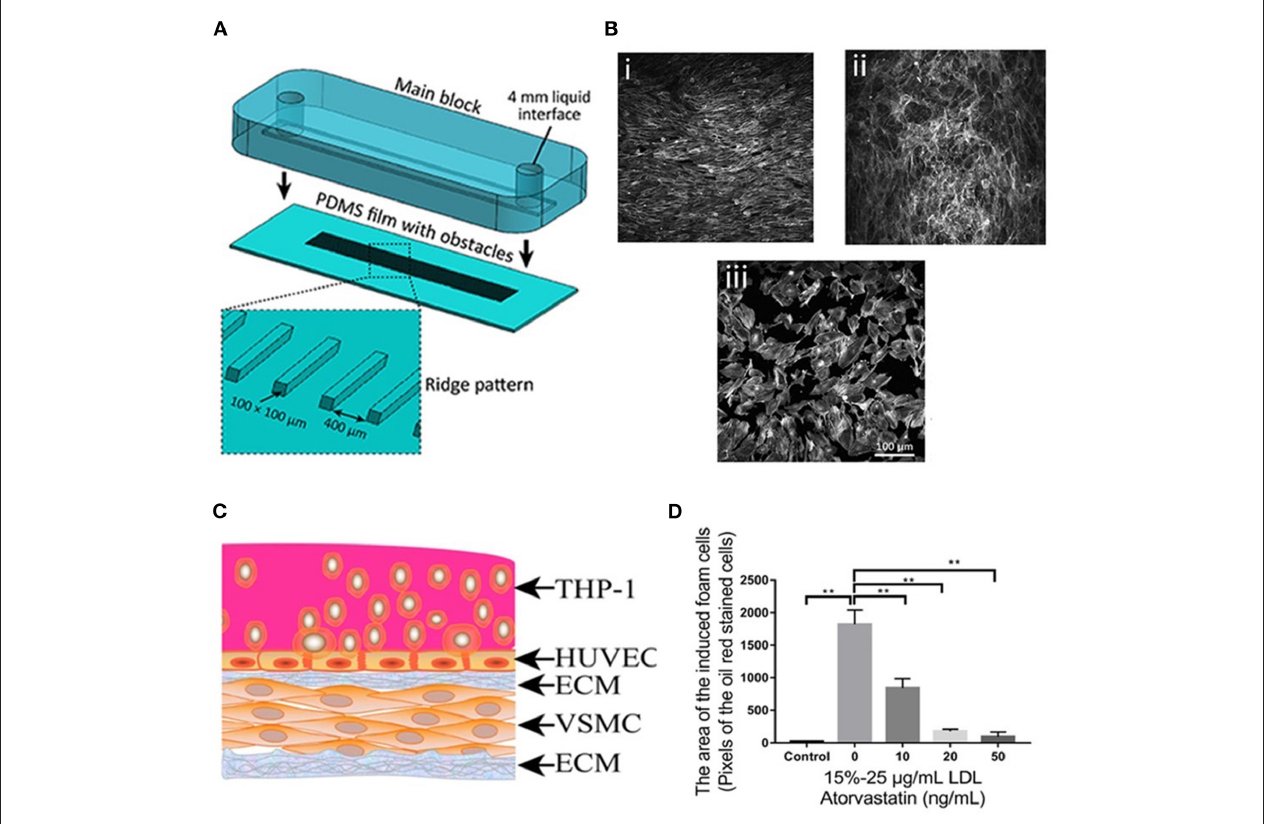
FIGURE 3 | (A) The process of assembling the main block and the PDMS substrate with ridge obstacles, with the inset showing the zoomed-in PDMS substrate. (B) A confluent layer of HAECs cultured under (i) laminar flow, (ii) disturbed flow, and (iii) static condition, following which the actin cytoskeleton was labeled with Atto 565-phalloidin. (C) Diagram of the co-culture model. (D) Foam cell formation after being treated with atorvastatin and LDL at different concentrations. Adapted, with permission from (130) (A,B) and (131) (C,D) . ** P < 0.01.